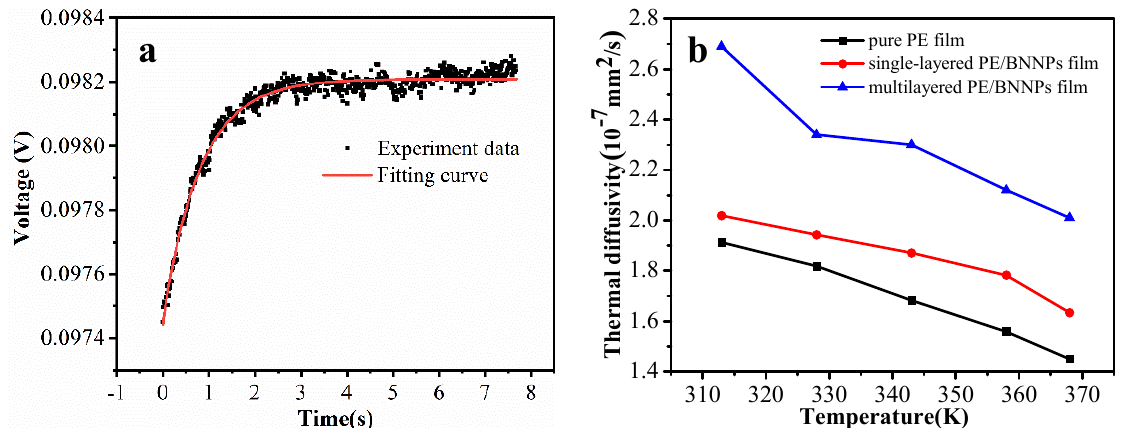
Figure 3. Thermal conductive property of different films. ( a ) Experiment data and fitting curve in the TET measurement of multilayered PE/BNNPs film sample. ( b ) Calculated in-plane thermal conductivity of different samples.